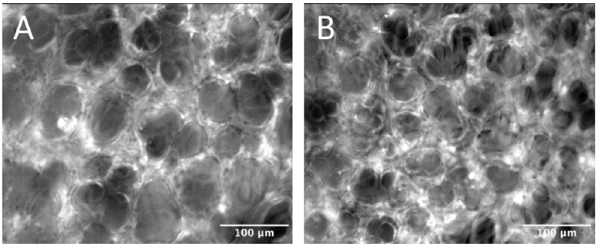
Figure 5. Intravital imaging of capillary perfusion in the pulmonary microcirculation. ( A ) Control group, ( B ) LPS group